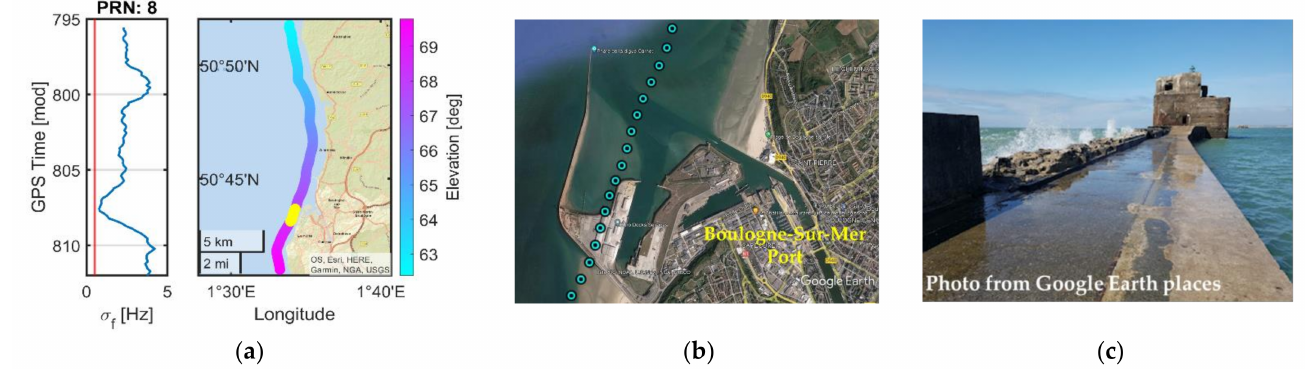
Figure 14. ( a ) Doppler spread of PRN 8 on 17 July 2019 plotted with vertical time axis aligned with the track on the map. ( b ) Specular point track crossing the pond created by the structure on the Google Earth satellite image. ( c ) Breakwater structure in the Boulogne-sur-Mer port located at 50 ◦ 43 (cid:48) 53 (cid:48)(cid:48) N 01 ◦ 34 (cid:48) 19 (cid:48)(cid:48) E. How the sea state changes from rough water on the left side to calm water on the right side can be